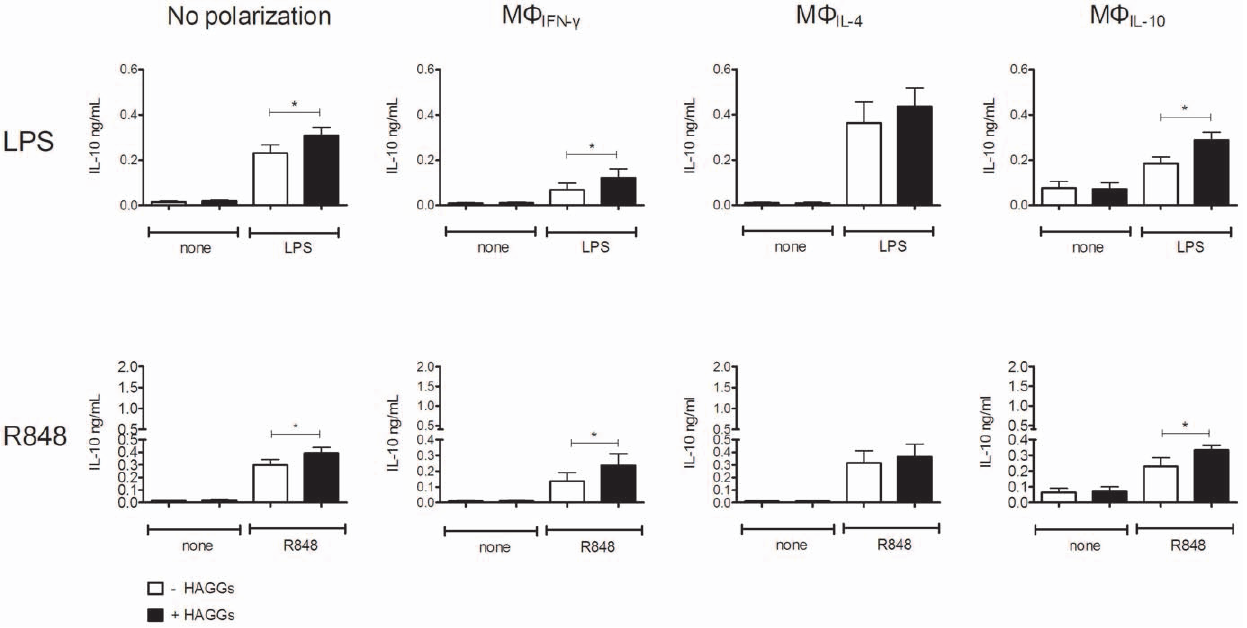
Figure 4. IL-10 production by M W IFN- c , M W IL-4 , and M W IL-10 after stimulation with HAGGs and LPS, or R848. Healthy peripheral blood monocytes were cultured for 4 days in medium or in medium supplemented with IFN- c , IL-4, or IL-10. Polarized macrophages were not stimulated, or stimulated for 20 hours with LPS, or R848, in the presence or absence of HAGGs. Bars represent the mean 6 SEM of 6 independent experiments. *p ,